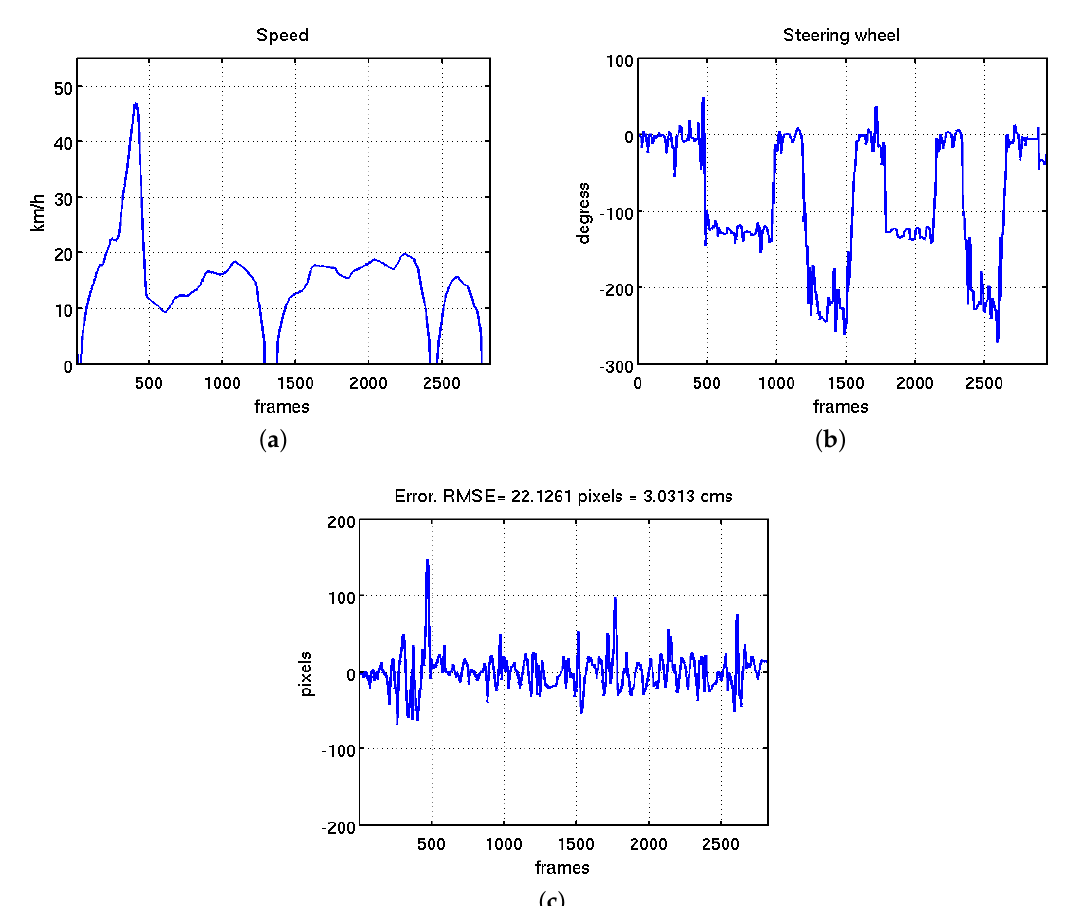
Figure 26. Evolution of the system under top city speed of 50 km/h and big speed changes. ( a ) Vehicle speed evolution with a top speed of 48 km/h; ( b ) evolution of the steering wheel; ( c ) evolution of the error measured in pixels, the value of RMSE for this test is equal to 3.0313